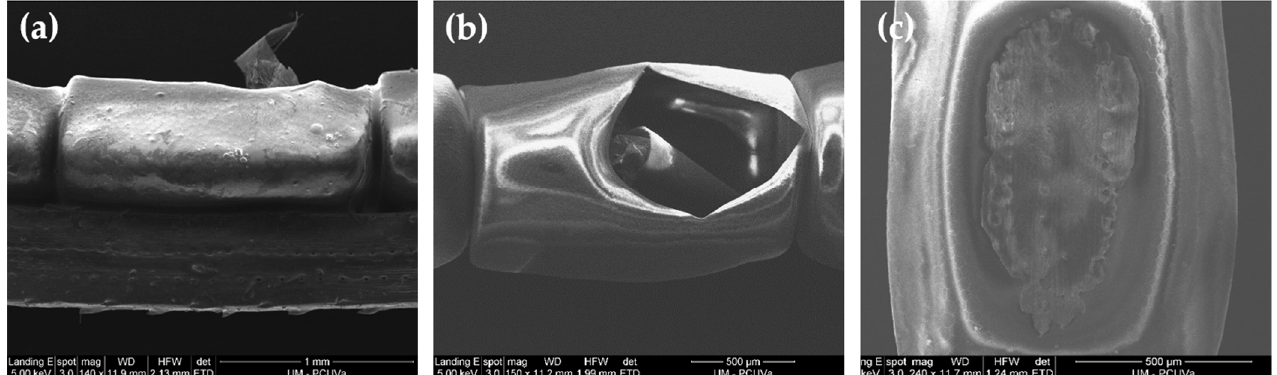
Figure 1. Scanning electron micrographs of L. occidentalis eggs and egg glue: ( a ) an egg on a pine needle; ( b ) a hatched egg; ( c ) egg glue.